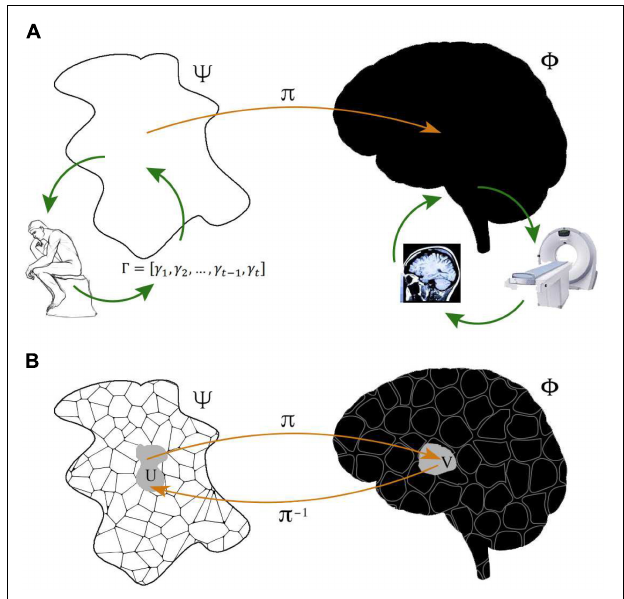
FIGURE 1 | Representation of system-level functional brain mapping. (A) Typical neuroimaging experiments are designed to reconstruct a space (cid:57) of cognitive or physiological functions, made behaviorally observable by performance measures (cid:48) from subjects at rest or carrying out given tasks, which can be associated, via some mapping π , with a space (cid:56) defined by some brain property, observed through some neuroimaging technique. Experiments may also address the somehow dual aim of reconstructing (cid:56) by using carefully selected cognitive of physiological probes, indirectly reflecting the space (cid:57) . Each neuroimaging technique documents specific neurophysiological phenomena (cid:56) Obs which result from brain activity (cid:56) NObs inaccessible to this particular technique. Note that functional brain activity (cid:56) is typically identified with the anatomical space with Cartesian coordinates, but may in principle represent any other brain feature. (B) (cid:56) and (cid:57) both have their own, usually non-trivial, structure i.e., a collection of elements together with a relation among them. The crucial point is that what is observed with a neuroimaging technique is not functional per se . Observed brain activity is genuinely functional if structure of the neurophysiological space (cid:56) is reflected by structure in (cid:57) . Accordingly, neuroimaging’s goal is to use the structure of one space to refine the structure of the other, for all the elements of these spaces. The problem addressed by functional brain imaging can be thought of as a fibe r bundle , in essence a family of spaces ( fibers ) parameterized by another space ( base ). Such a structure can be used to define properties that are useful when gauging the significance of observed brain